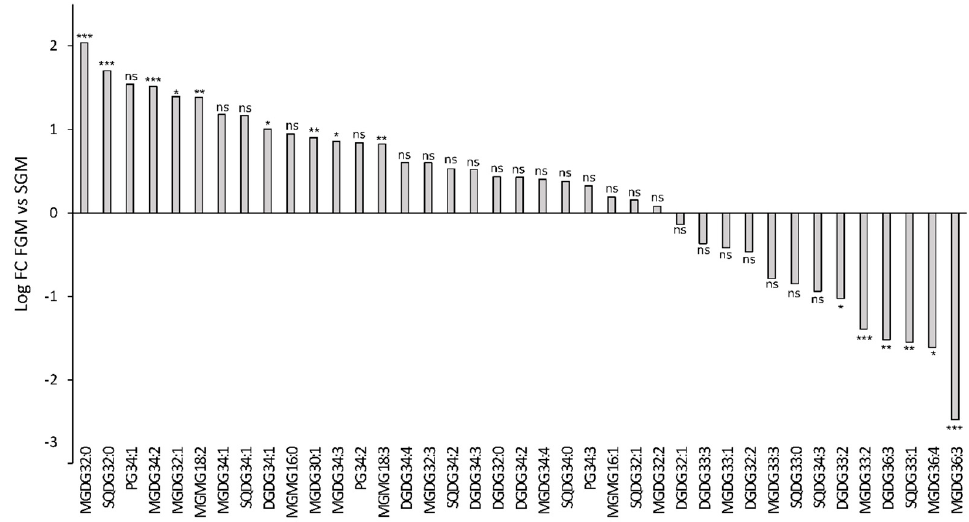
Figure 4. Comparison of abundance of selected lipid species detected in cells of Synechocystis sp. PCC 60803 cultivated in FGM and in SGM. Fold-changes were calculated by dividing the average peak area of a given lipid species detected in samples obtained in FGM ( n = 6) by the average peak area of the same lipid species detected in samples obtained in SGM ( n = 6). The log 2 fold-change values are presented: positive values correspond to higher peak area in FGM compared to SGM, while negative values represent peak areas higher in SGM in comparison to FGM. Mann-Whitney unpaired analysis, * p < 0.05, ** p < 0.01, *** p < 0.005, ns: not statistically significant difference.